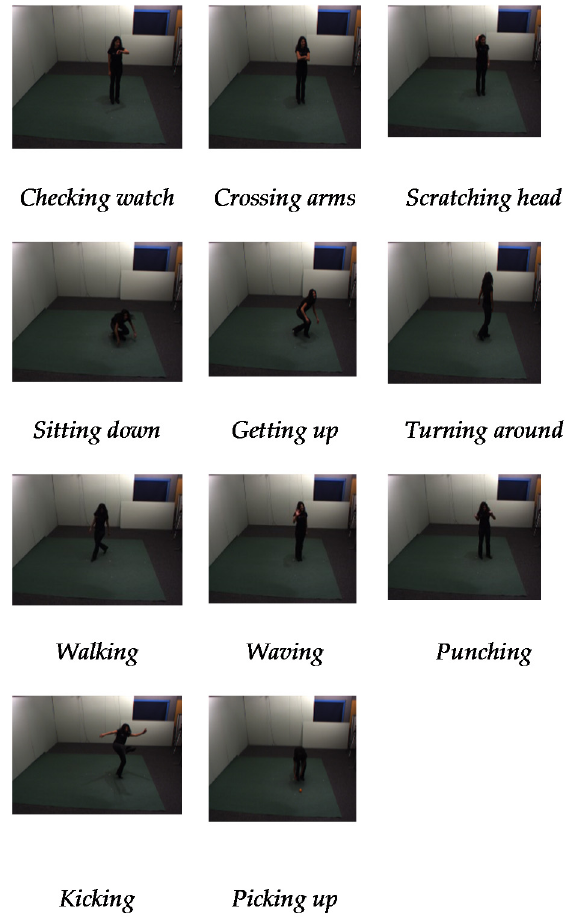
Figure 6. Selected 11 actions in IXMAS dataset. Table 1. Action class names used in experimentation.